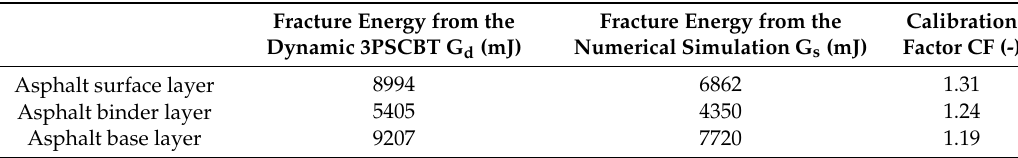
Table 5. Fracture energy for the